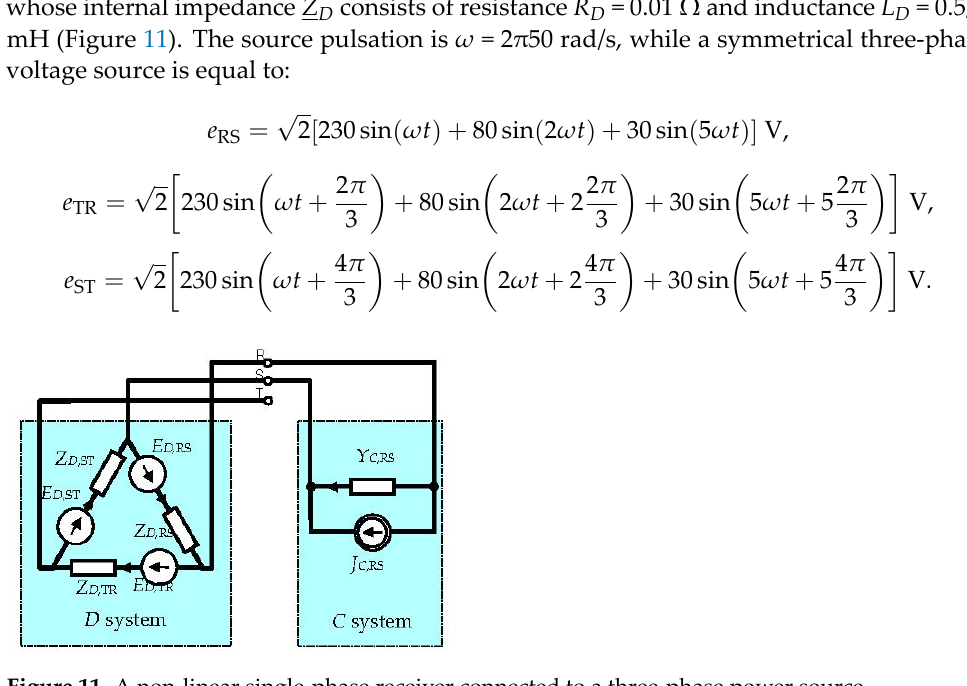
Figure 11. A non-linear single-phase receiver connected to a three-phase power source. Figure 11. A non‑linear single‑phase receiver connected to a three‑phase power source. The calculation results are presented in Tables 1 and 2.